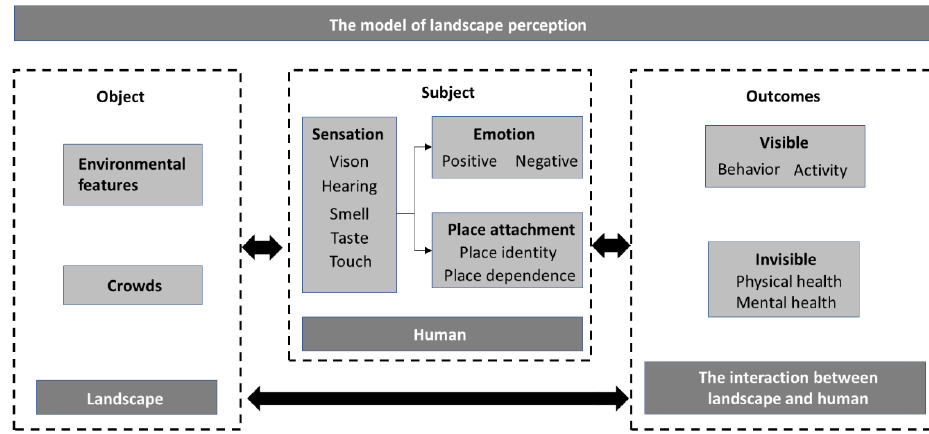
Figure 1. Landscape perception